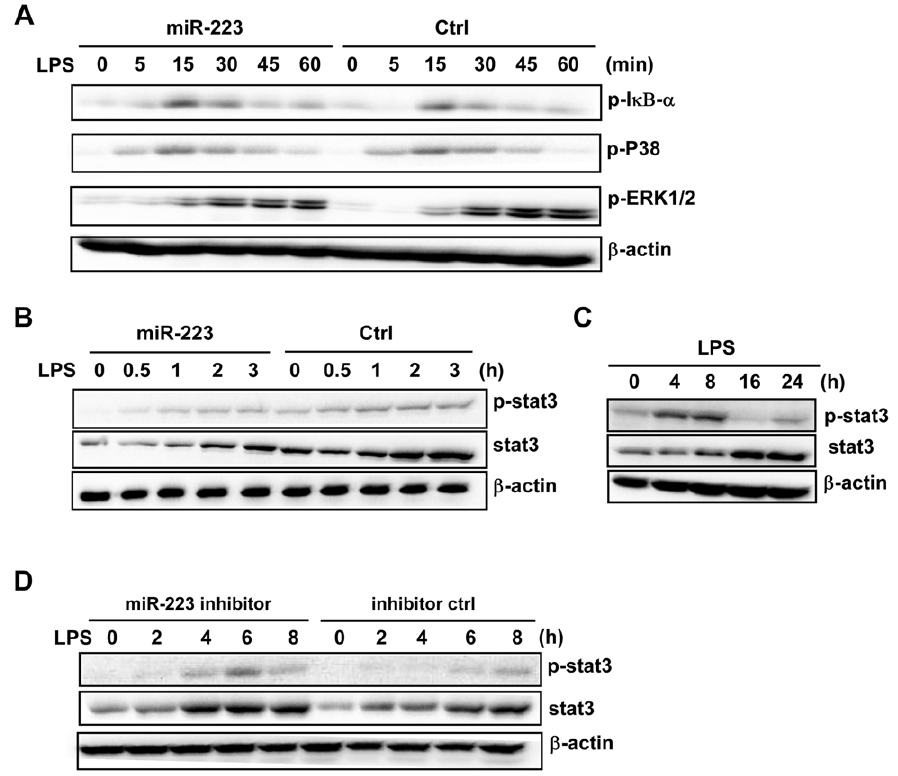
Figure 4. MiR-223 negatively regulates LPS-induced STAT3 activation in macrophages. (A) RAW264.7 cells were transfected with control and mimics of miR-223 at a final concentration of 30 nM, then stimulated with LPS (100 ng/ml) for the indicated time points. P-I k B- a , p-ERK1/2 and p- P38 were analyzed by immunoblotting. (B) RAW264.7 cells were treated as described above. Phosphorylated and total STAT3 were detected by immunoblotting. (C) RAW264.7 cells were stimulated with LPS for the indicated time points and STAT3 protein expression was measured by immunoblotting. (D) RAW264.7 cells were transfected with miR-223 inhibitors at a final concentration of 30 nM, and stimulated with LPS for the indicated time points, then the phosphorylated and total STAT3 protein were determined. The data shown represent three independent